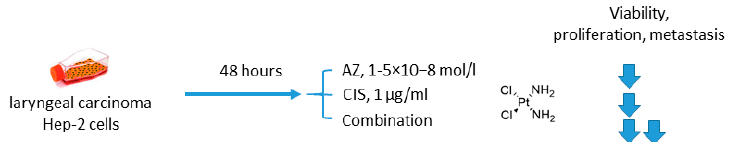
Figure 3. Graphical outline of the study on AZ+CIS combination reported by [46].